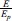
Relative evaporation EEp as a function of relative evaporating area (a-d) from Zebrina pendula leaves.The symbols depict relative transpiration rates for several stomata apertures ranging from 1 to 20μm and a mean density of 1625 cm-2 based on measurements of Bange [33] in still air. The short-dashed line corresponds to estimates that consider diffusive resistance from single pores only (Eq 7). The large-dashed line corresponds to estimates that neglect interactions between neighboring stomata. The solid line corresponds to estimates based on Eq 10 that express the effect of all three resistances depicted in Fig 2.